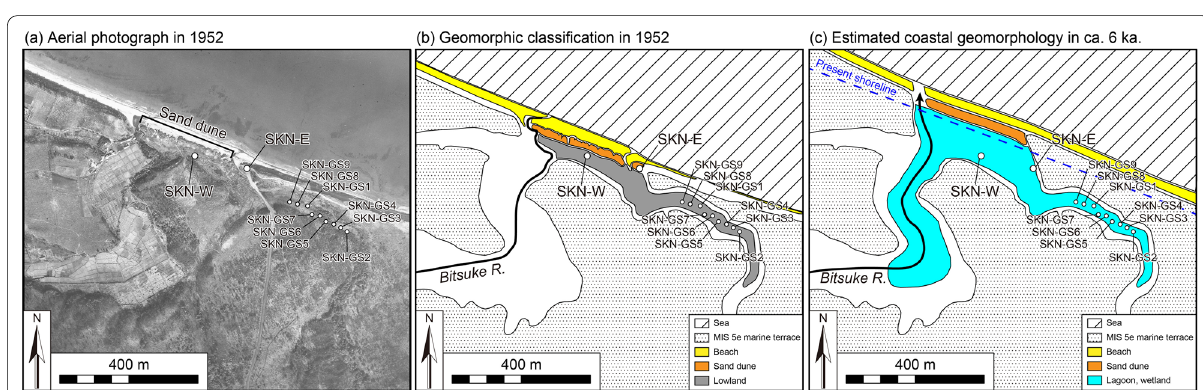
Fig. 10 Geomorphic change in Sekinehama. a Aerial photograph in 1952, obtained from GSI. It was geo-referenced in ArcGIS. b Geomorphic classification in 1952. c Paleogeography in ~ 6 ka, based on the work of Hiramine et al. (in